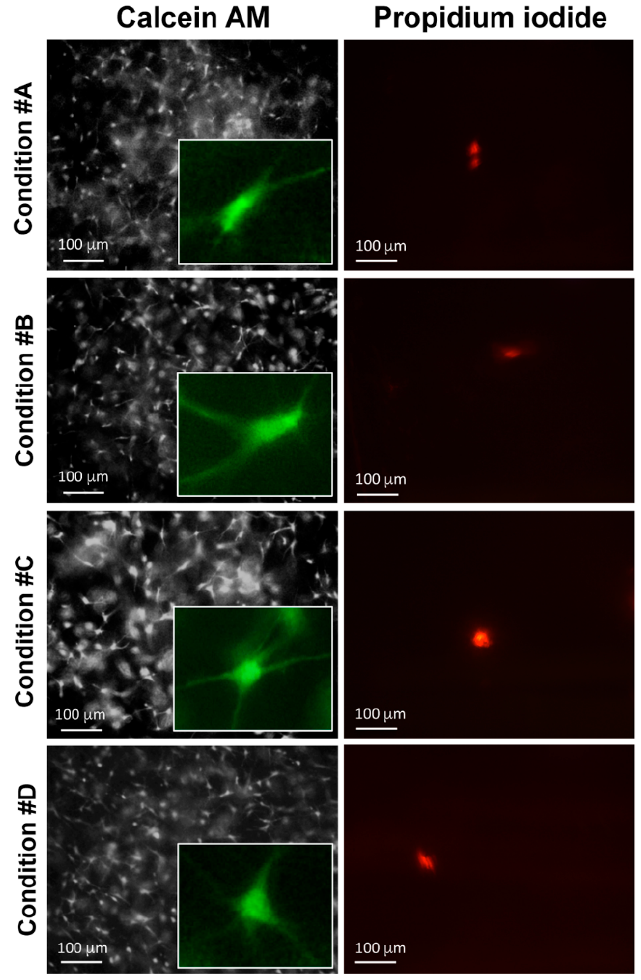
Figure 6. Live/dead fluorescence microscopy of fibroblasts embedded within collagen gels.